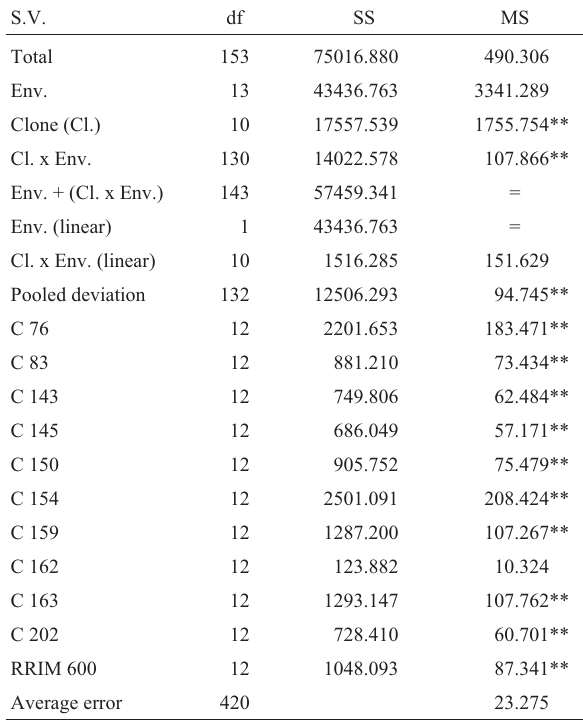
Table 5 - Components of stability mean squares of latex yield of eleven Hevea clones (Cl.) in 14 environments (Env.)-seven years x two locations (Akwete and Etche)-Eberhart and Russell